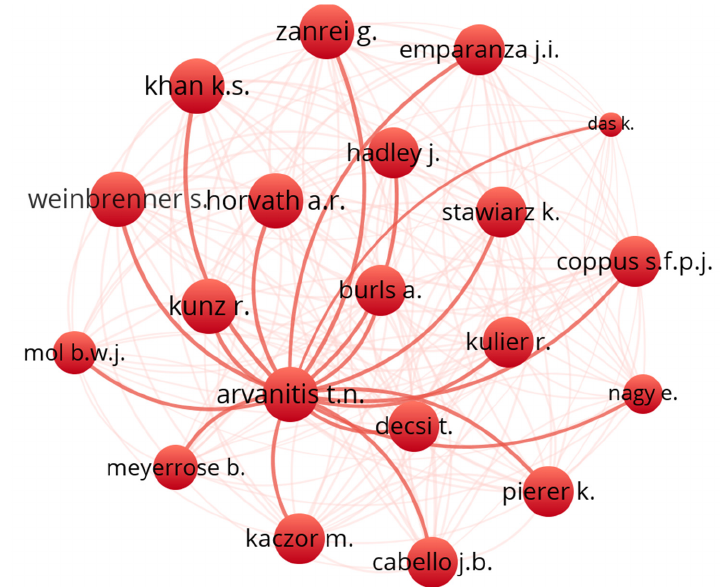
Figure 17. Network Visualization map of the largest set of authors’ collaboration in performance evaluation in e-LMED. Cluster 1 (color-coded red) shows the collaboration between 12 authors, while cluster 2 (color-coded green) shows the collaboration between eight